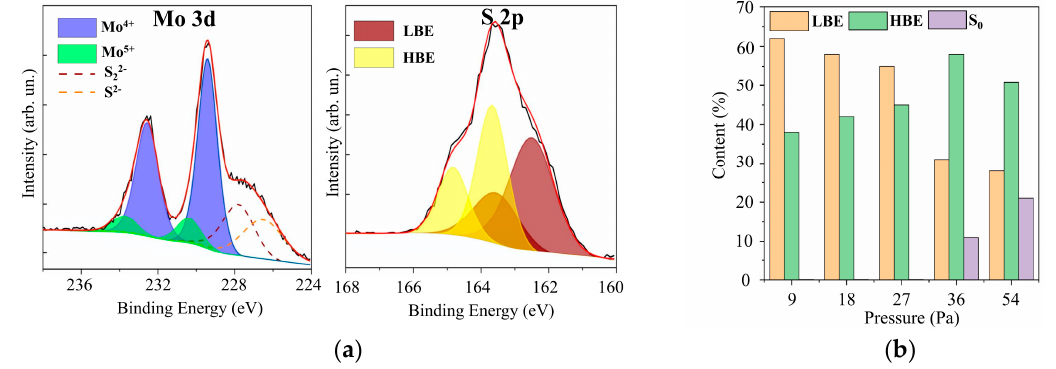
Figure 7. ( a ) The XPS Mo 3d and S 2p spectra for a MoS 4.5 film obtained by RPLD at an H 2 S pressure of 27 Pa; ( b ) the relative content of low binding energy (LBE), high binding energy (HBE), and S 0 states of sulfur atoms in MoS x films obtained by RPLD at different pressures of H 2 S gas.